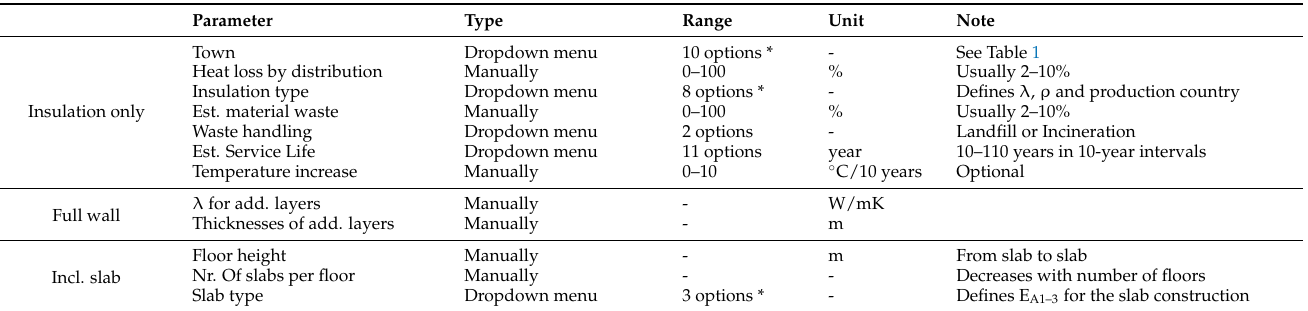
Table 2. Introduction to the necessary inputs for Scen ins as well as the mandatory information for Scen wall and Scen slab . The * marks an additional option called “User-defined”.